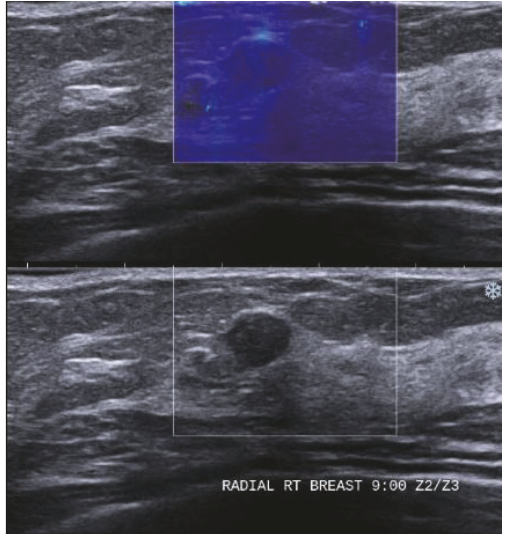
Figure 2: Target ultrasound corresponding to mammogram, there is partially marginated hypoechoic mass noted at 9 o’clock mid to posterior third of the right breast measuring 0.7 × 0.8 × 0.5 cm. This mass shows tubular extension from the lateral aspect and shows no internal vascularity. This mass appears relatively soft in